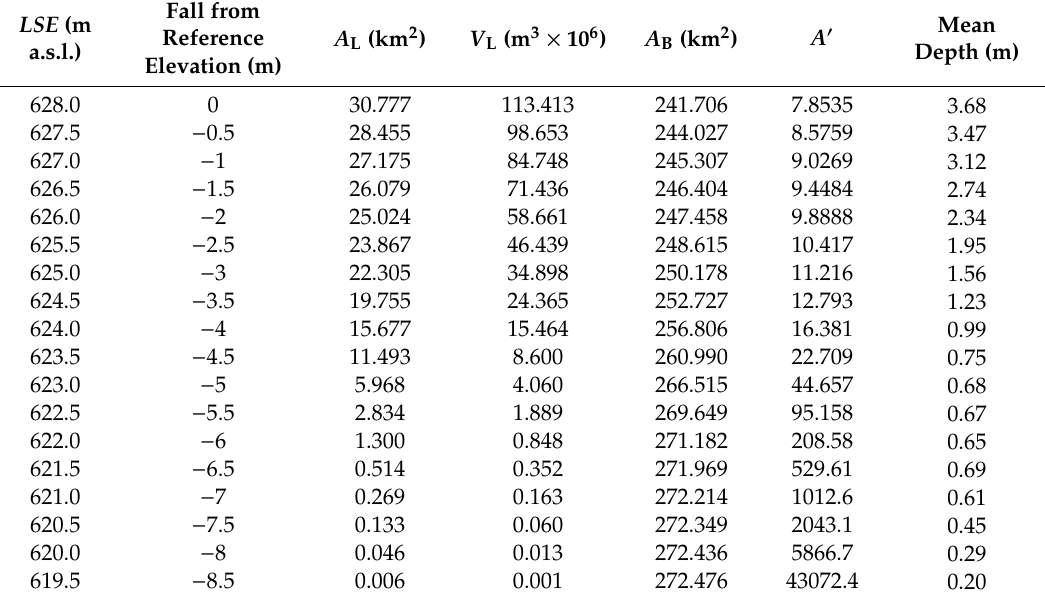
Table 2. Lake surface A L , lake volume V L , basin area that drains to the lake A B , A B / A L and mean depth of the lake for di ff erent values of lake surface elevation ( LSE ) considering A T = 272.48 km 2 (grey zone plus the lake in Figure